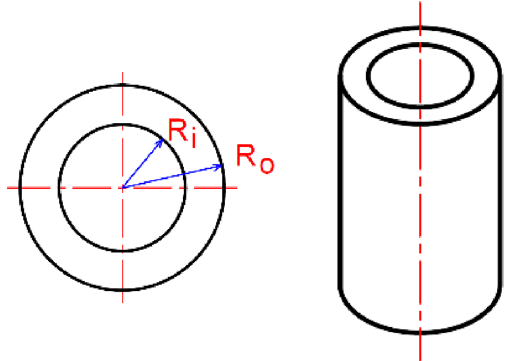
Fig. 2 Schematic drawing of a thick-walled